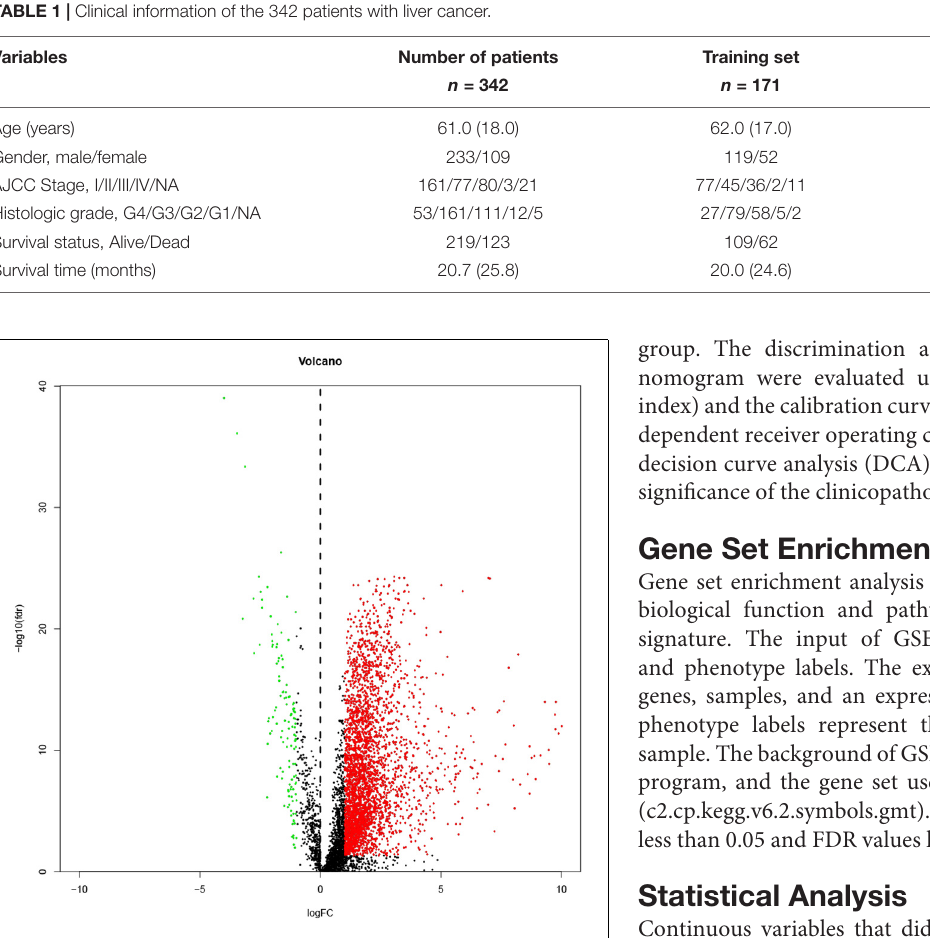
FIGURE 1 | A volcano map showing all lncRNAs. Black dots represent insignificant lncRNAs in tumor tissues; green and red dots represent down-regulated and up-regulated lncRNAs in tumor